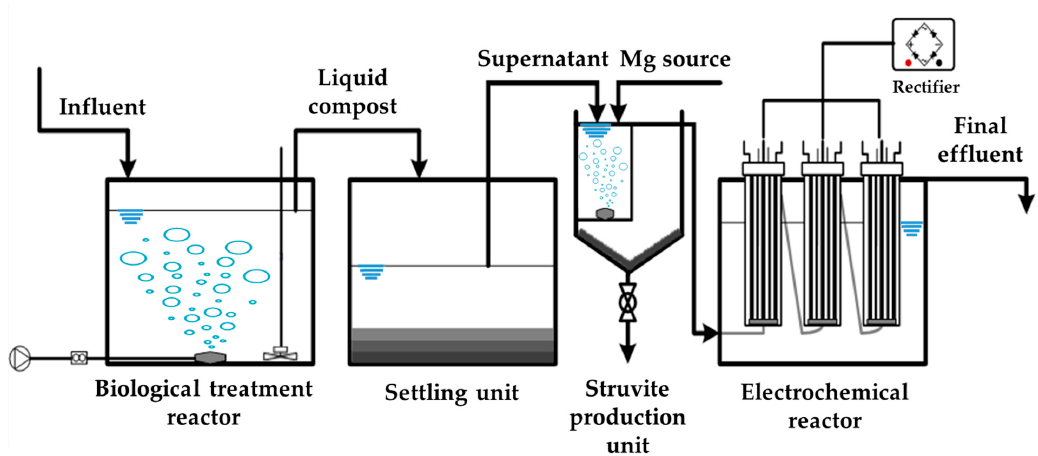
Figure 1. Schematic of the lab-scale treatment process.